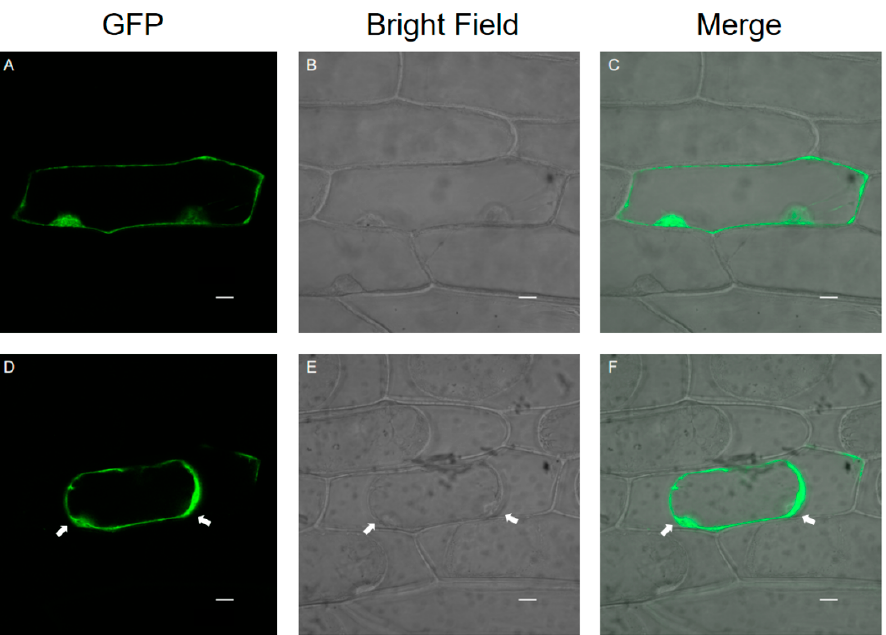
Figure 3. Subcellular localization of SlPG49-GFP fusion protein in living onion epidermal cells: ( A – C ) localization of SlPG49-GFP; ( D – F ) localization of SlPG49-GFP in plasmolyzed onion epidermal cells; cells were plasmolyzed by treatment with 1 mol·L − 1 mannitol for 5 min. White arrowheads show the membranes separated from the cell wall. Bars = 20 μ m.